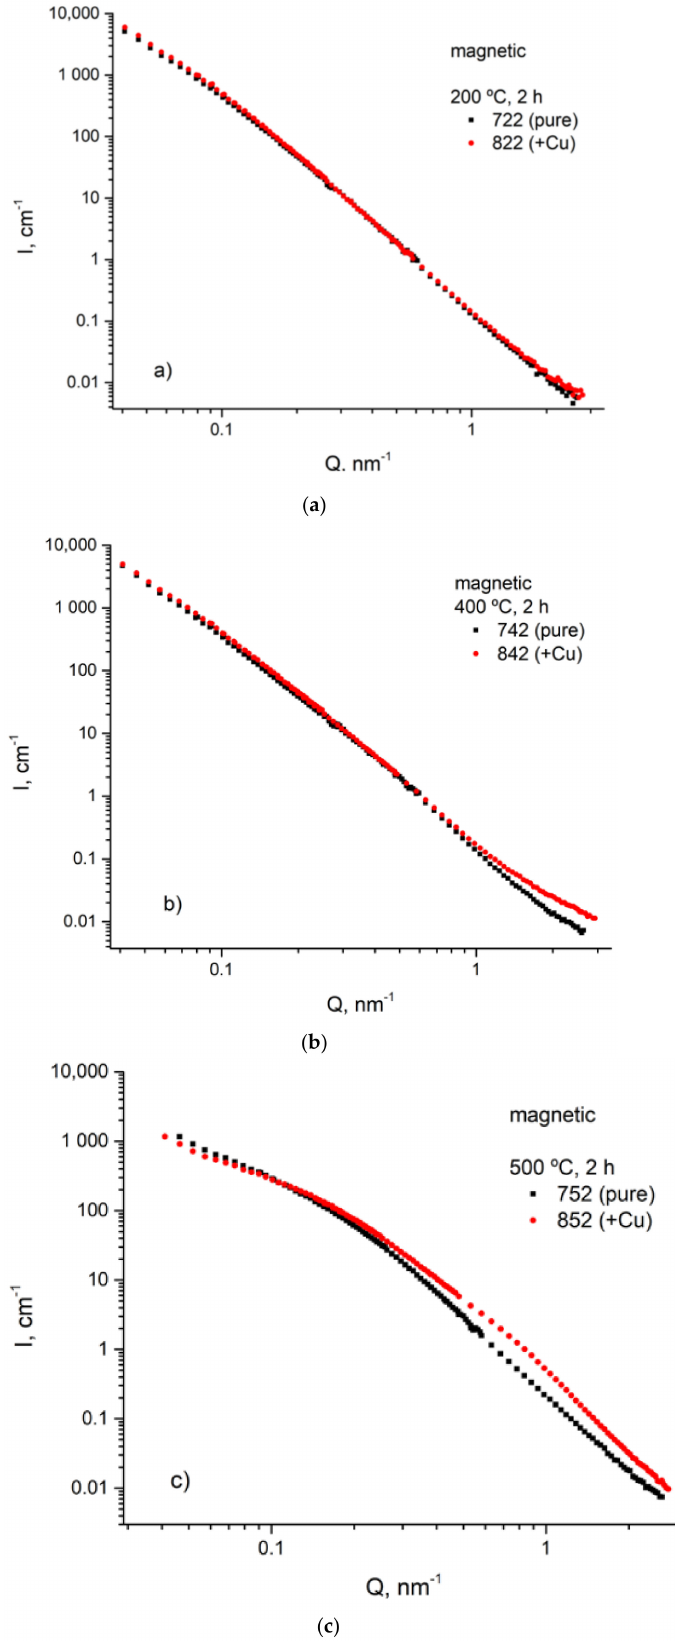
Figure 15. Magnetic SANS curves for samples tempered at 200 ◦ C ( a ), 400 ◦ C ( b ), and 500 ◦ C ( c ) (42SiCr steel—black squares, 42SiCr + Cu steel—red